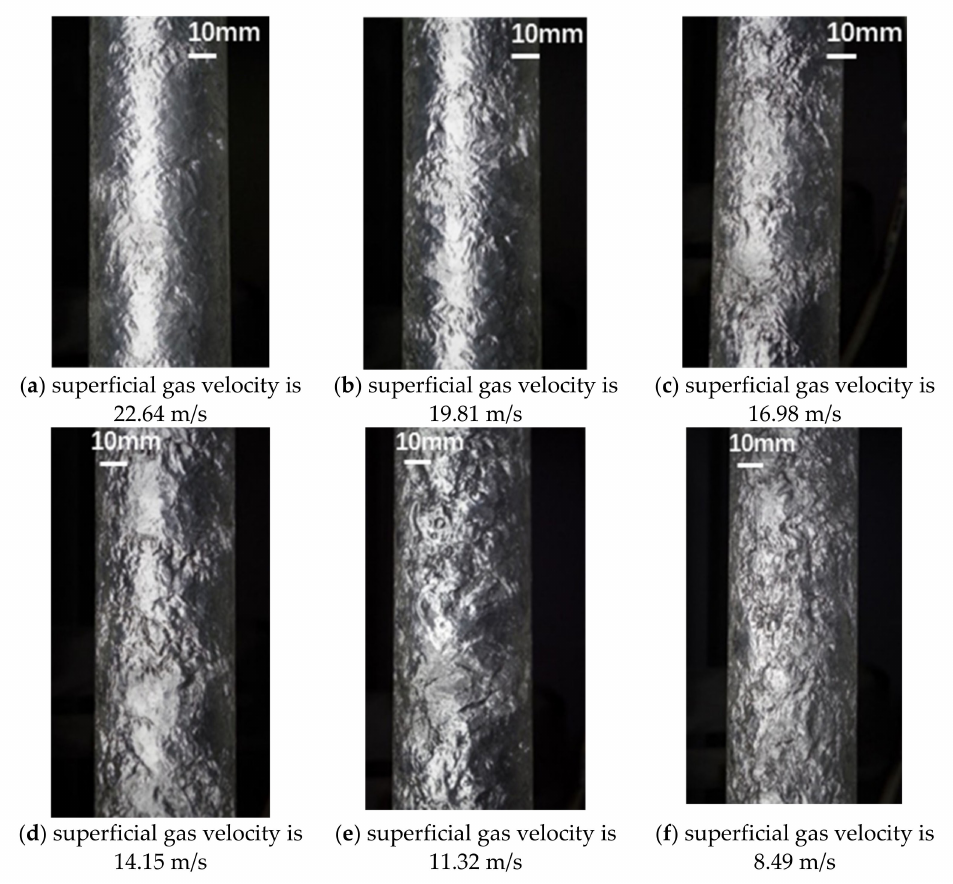
Figure 10. Image recording (the superficial liquid velocity is 0.028 m/s).